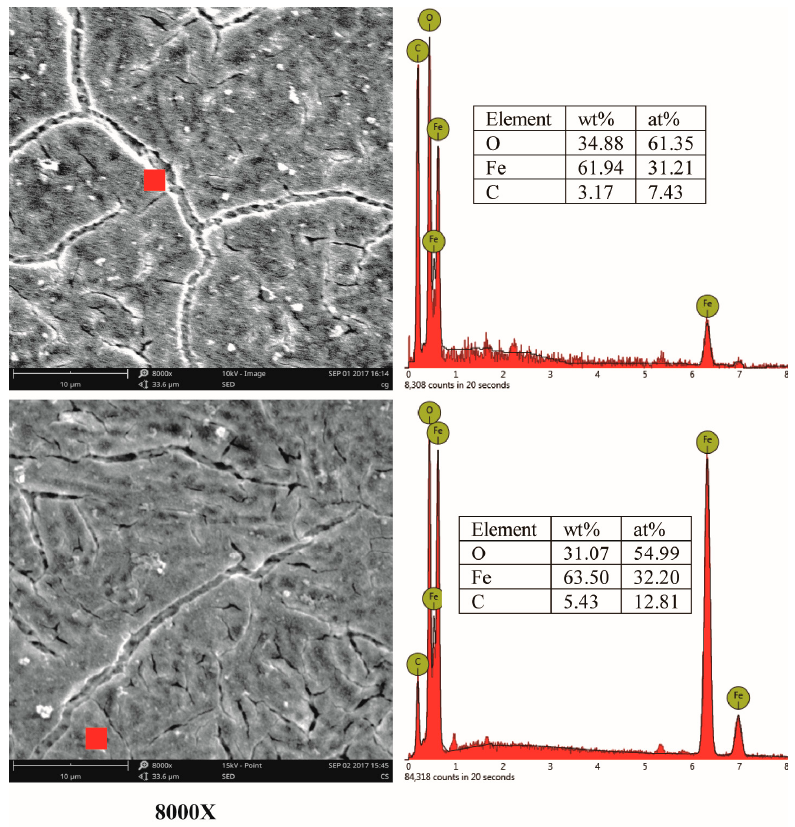
Figure 8. Surface corrosion morphology and EDS spectrum analysis of 35CrMoV corrosion surface: ( a ) un-ultrasonic-aided; ( b ) ultrasonic-aided.